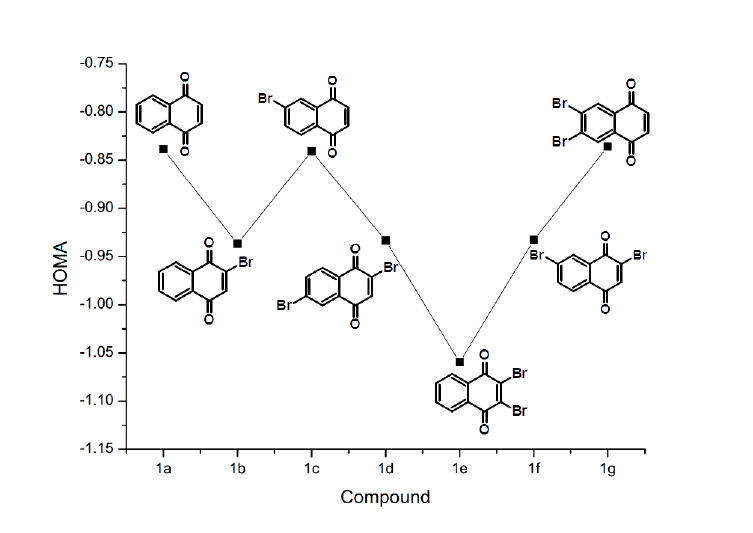
Figure 2. The HOMA aromaticity index evolution of the quinoid ring as a result of substitution by –Br in the compounds of group 1